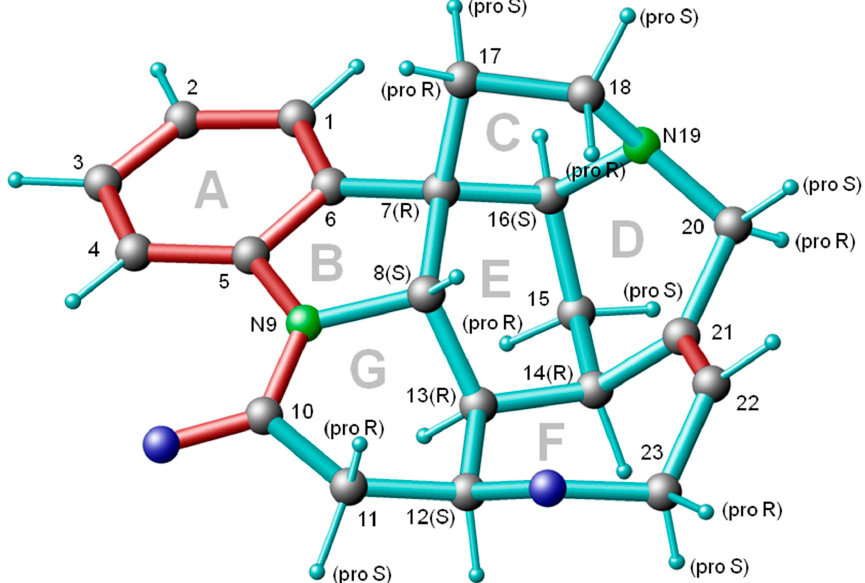
Figure 1. Structure of strychnine [8] with carbon and nitrogen labeling. For CH 2 groups, the pro-chiral assignment is given. Conjugated π -bonds and double bonds are indicated in red color. The first evidence for the second conformer of strychnine came from precise nuclear Overhauser effect (NOE) measurements of interproton distances of the dissolved strych- nine in solution [11]. From inspecting the NOE-measured distance between H11(proR) and H23(proR), Butts et al. [11] concluded that there should exist another low-populated conformer with a different position of the CH 2 group of the F ring that leads to a shorter average distance compared with the crystal structure [8].